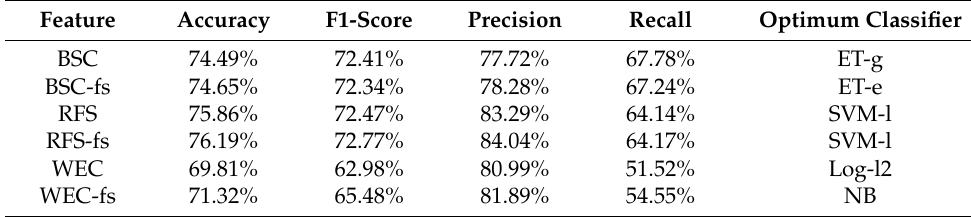
Table 3. Optimal model performance of a single feature.